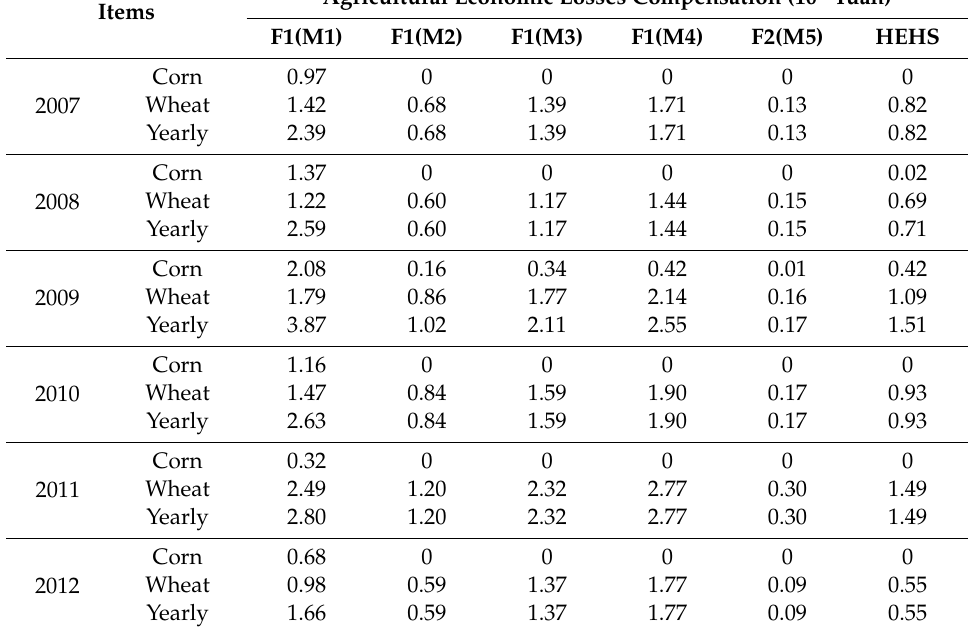
Table 3. Compensation for agricultural economic losses caused by restoration of the healthy eco- hydrological sequence of